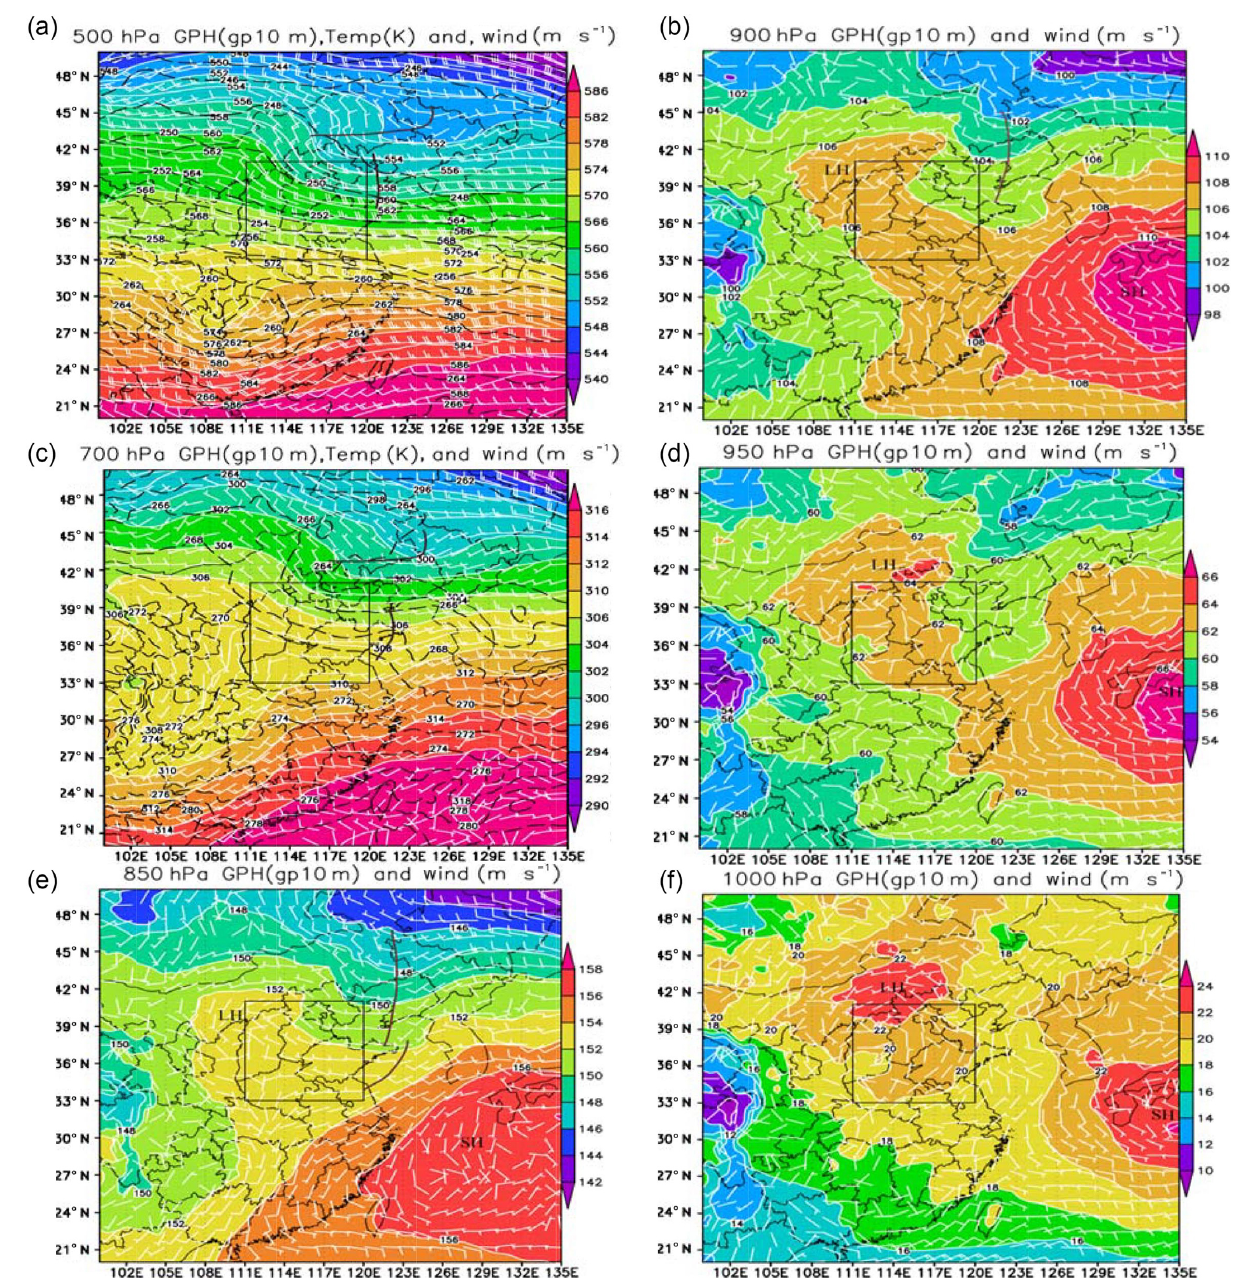
Figure 2. Geopotential height (GPH; coloured shading; gp10m), temperature (dashed black contours; K), and wind (wind bars;ms − 1 ) in the (a) upper (500hPa) and (c) middle (700hPa) atmosphere, and geopotential height and wind in the (e) lower atmosphere (850hPa) and (b, d, f) the PBL (900, 950, 1000hPa), at 00:00 UTC on 19 December